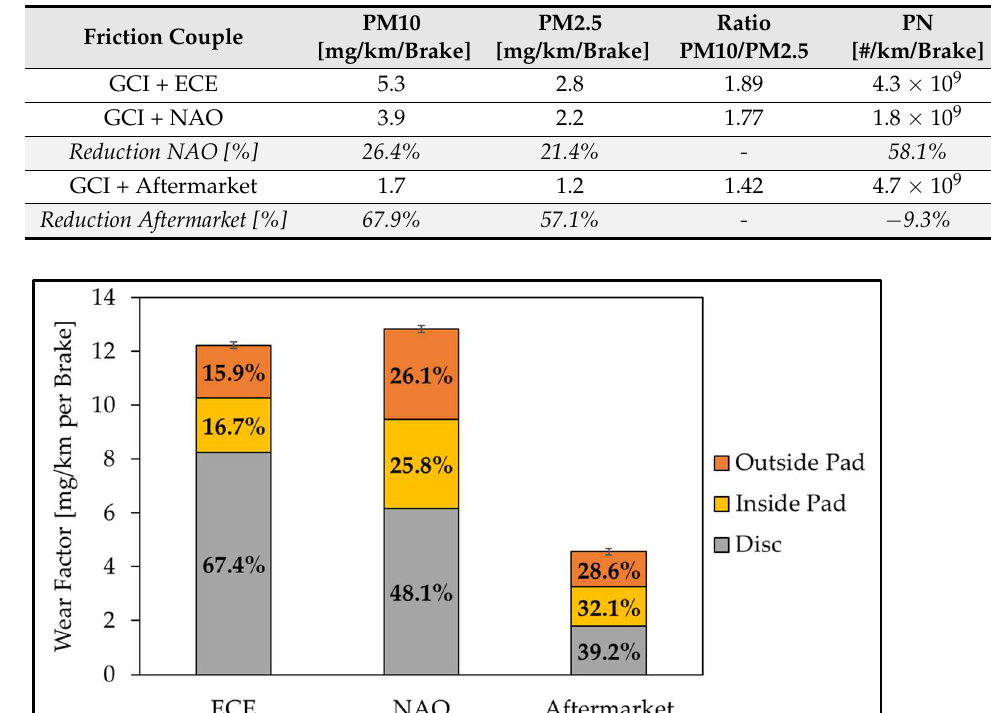
Table 7. Emission factors of the three different brake pad compositions.